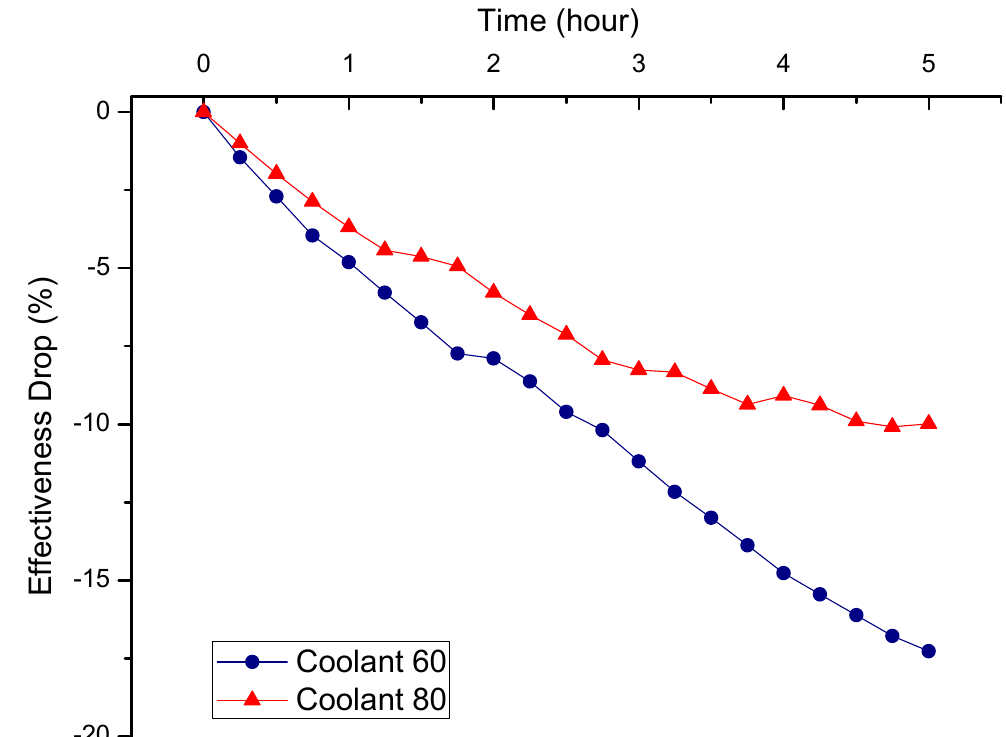
Figure 5. Effectiveness drop over the course of 5 h with respect to different coolant temperatures.